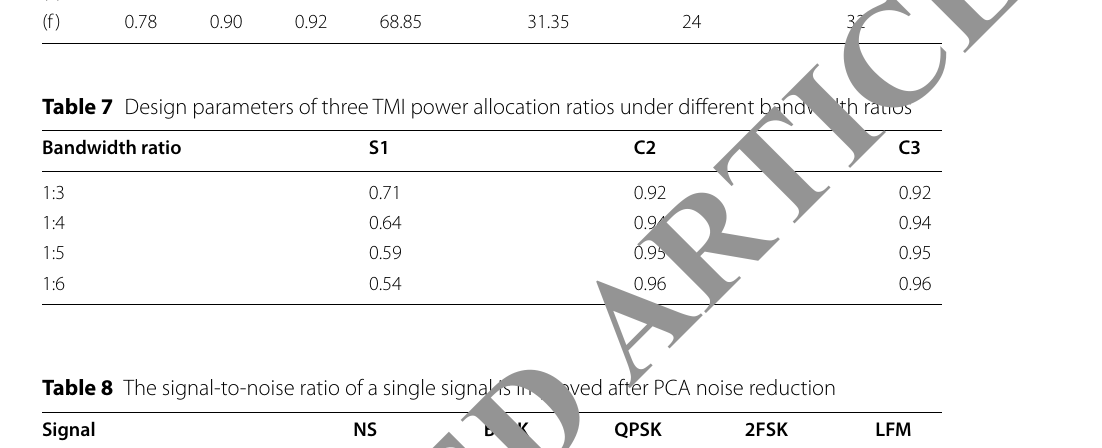
Table 8 The signal-to-noise ratio of a single signal is improved after PCA noise reduction Signal NS BPSK QPSK 2FSK LFM Reconstruction degree 98% 0.5–2.0 = Reconstruction degree =